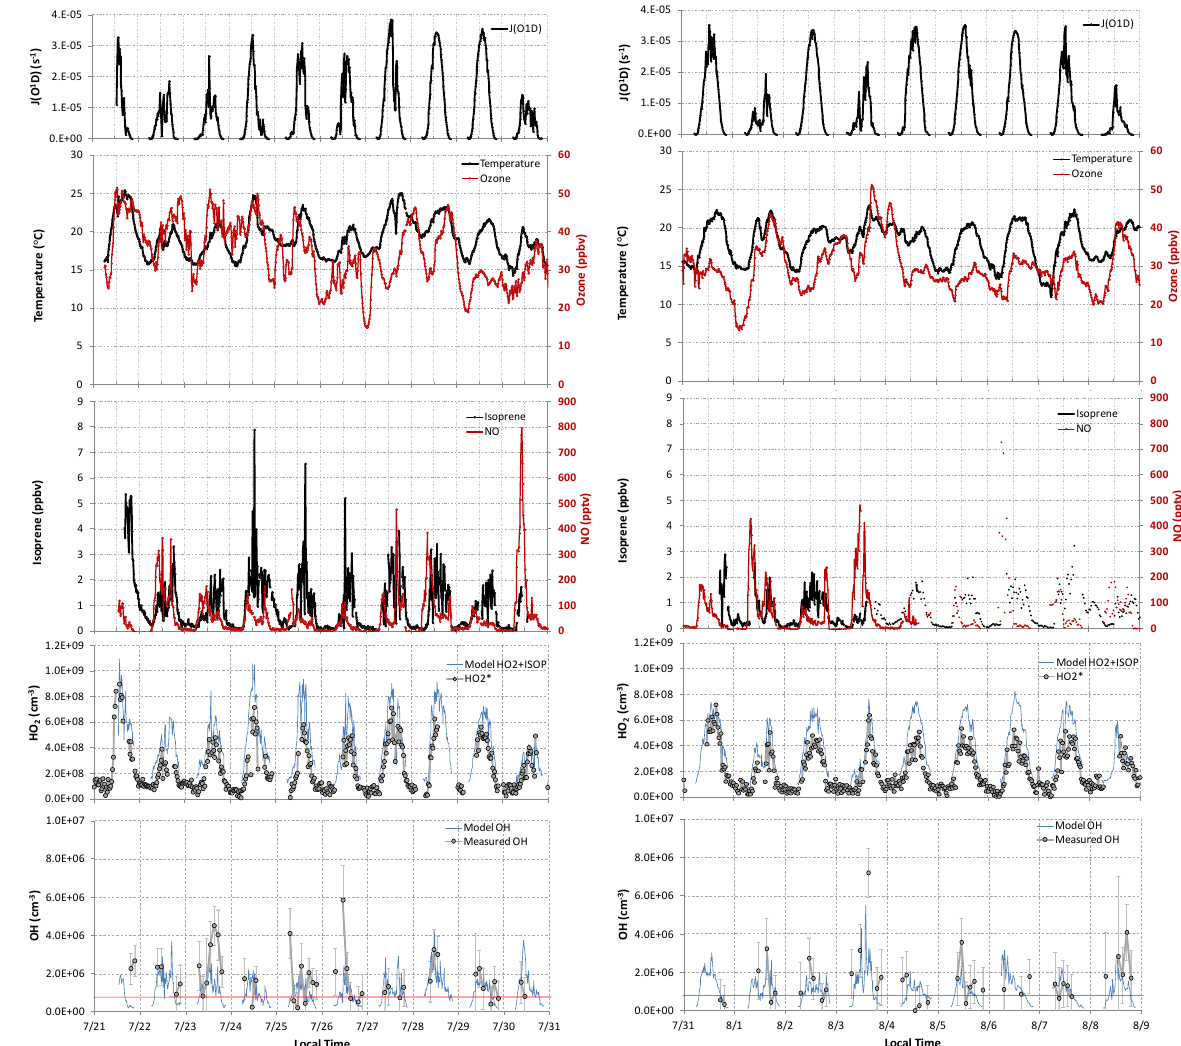
Figure 2 (continued) Fig. 2. CABINEX 2009 data showing key constraints and modeled and measured OH and HO ∗ concentrations. Error bars on the OH 2 precision (not shown) is approximately 1.5 × 10 7 cm − 3 . 2